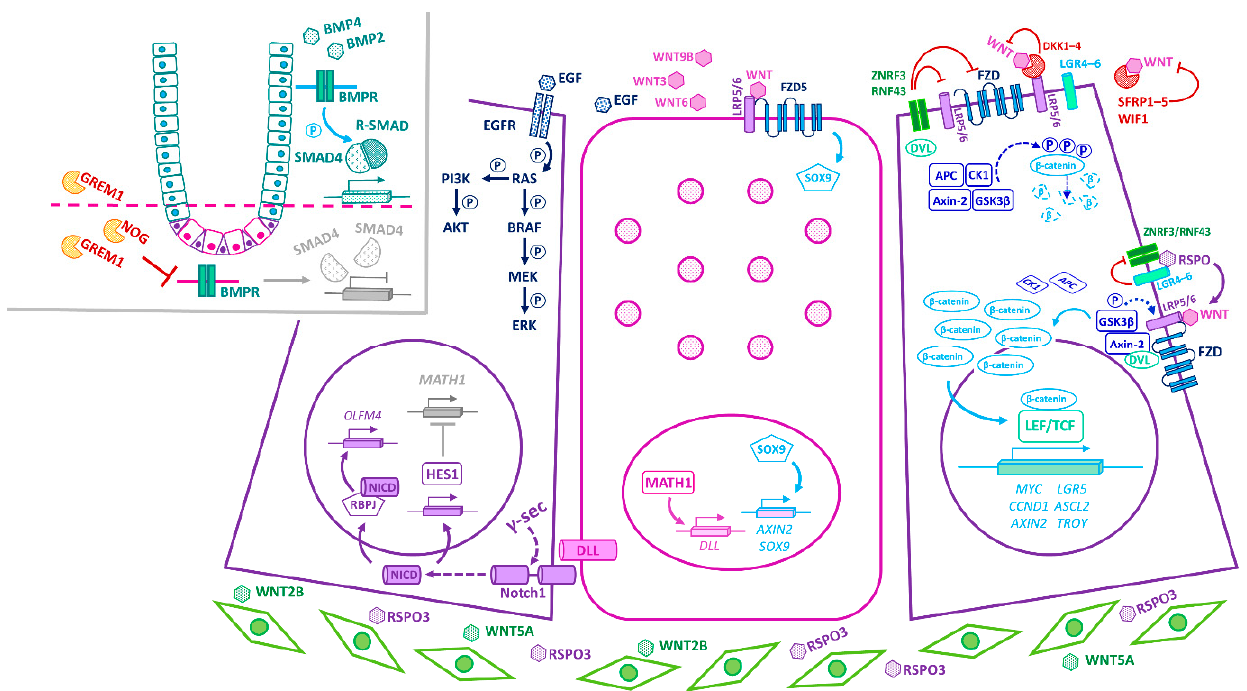
Figure 3. Principal niche-signalling pathways in small-intestinal homeostasis. The schematic represents LGR5 + ISCs within the niche at the crypt base, flanked by Paneth cells (centre) and pericryptal fibroblasts. Key components of the Wnt, Notch, BMP, and EGF pathways are indicated. Paneth cells present membrane-bound Notch ligands (DLLs) and secrete WNT3, WNT6, WNT9B, and EGF, as well as antimicrobials and lactate (not shown). Multiple pericryptal fibroblast populations differentially secrete agonists and antagonists of key niche pathways along the vertical crypt axis. Upper right : In the absence of RSPO-binding, the WNT-receptors FZDs (FZD1–10) are targeted for degradation by the E3-ubiquitin ligases RNF43 and ZNRF3. Furthermore, the Wnt antagonists SFRPs (SFRP1–5) and WIF1 sequester secreted WNT ligands, whereas DKKs (DKK1–4) bind to the LRP5/6 receptors, preventing WNT-ligand binding. Consequently, cytoplasmic β -catenin is bound by the scaffolding proteins APC and Axin-2, and sequentially phosphorylated by the kinases CK1 and GSK3 β , marking it for proteasomal degradation. Lower right : RSPOs (RSPO1–4) bind the LGR-family of receptors (LGR4–6) and potentiate canonical Wnt signalling by inhibiting the degradation of FZDs by RNF43 and ZNRF3. Upon binding of WNT ligands to their cognate FZD and LRP co-receptors, DVL and Axin-2 are recruited to the membrane, triggering the phosphorylation of LRP5/6 by GSK3 β . This, in turn, culminates in the dissociation of the destruction complex, leading to stabilization of β -catenin and its translocation to the nucleus, where it drives LEF/TCF-dependent transactivation of Wnt-target genes. Lower left and middle : Binding of Notch ligands (DLL1, DLL4), on the surface of Paneth cells, to juxtaposed Notch receptors (NOTCH1, NOTCH2) of adjacent LGR5 + ISCs triggers the proteolytic release of NICD, resulting in Notch-pathway activation in LGR5 + ISCs and its suppression in Paneth cells. As a result, the transcriptional repressor HES1 is activated in LGR5 + ISCs and ISC-associated markers are transcribed. In Paneth cells, the transcription factor MATH1 enhances DLL expression, and WNT/FZD5 transduction drives SOX9-dependent differentiation and expression of Wnt-target genes ( AXIN2 , SOX9 ) but not stemness genes ( ASCL2 , LGR5 ). Upper left : Binding of EGF to EGFR activates multiple downstream signalling cascades, including the RAS/BRAF/MEK/ERK and PI3K/AKT pathways which promote proliferation and survival, respectively. Inset : BMP activity forms a decreasing gradient from the intestinal lumen to the crypt base. Near the lumen, BMP signal transduction is initiated upon the binding of BMP ligands to their cognate BMPR receptors, leading to phosphorylation of R-SMADs, formation and nuclear translocation of R-SMAD/SMAD4 complexes, and transactivation of target genes involved in differentiation, cell-cycle withdrawal, and apoptosis. At the crypt base, pericryptal stromal cells secrete BMP antagonists (GREM1, CHDL1), protecting ISCs and progenitors from the cytostatic effects of BMPs. Infiltrating immune cells, endothelial cells, enteric neurocytes, and ECM components that also contribute to the niche are not shown. Solid arrows indicate direct activation, dashed arrows signify multiple intermediary steps, lines ending with a bar denote inhibition, grey colouring indicates suppression/inactivation, and circled P indicates phosphorylation.